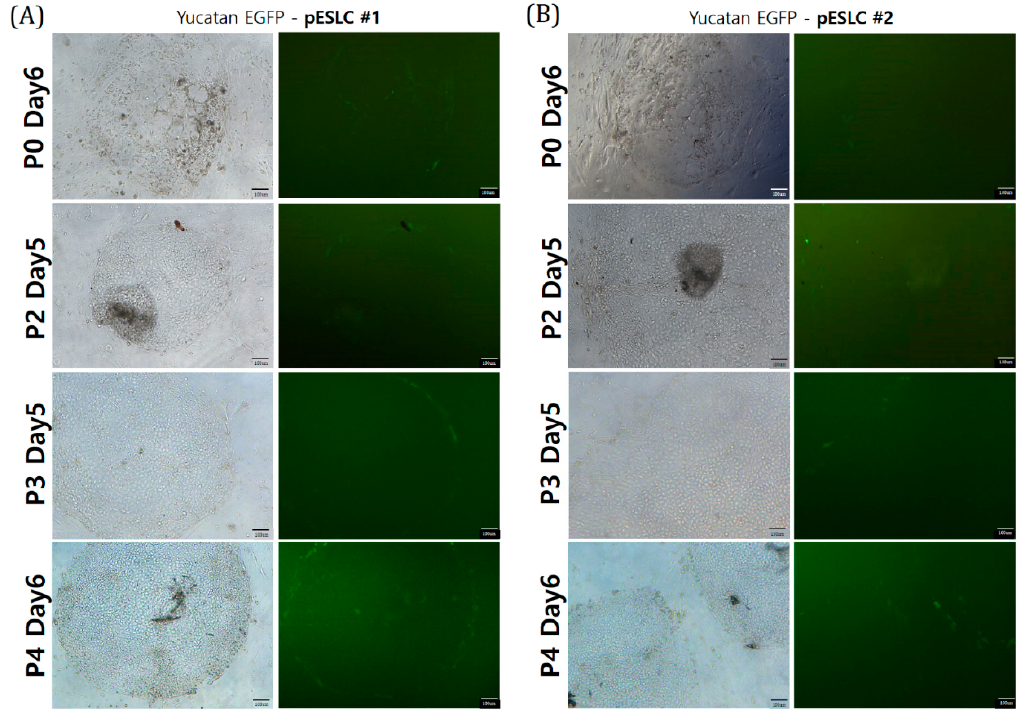
Figure 2. Morphology and EGFP expression of two pESLC lines ( A , B ). The pESLC lines derived from SCNT embryos from a Yucatan donor cell with EGFP. Scale bars 100 µ m.